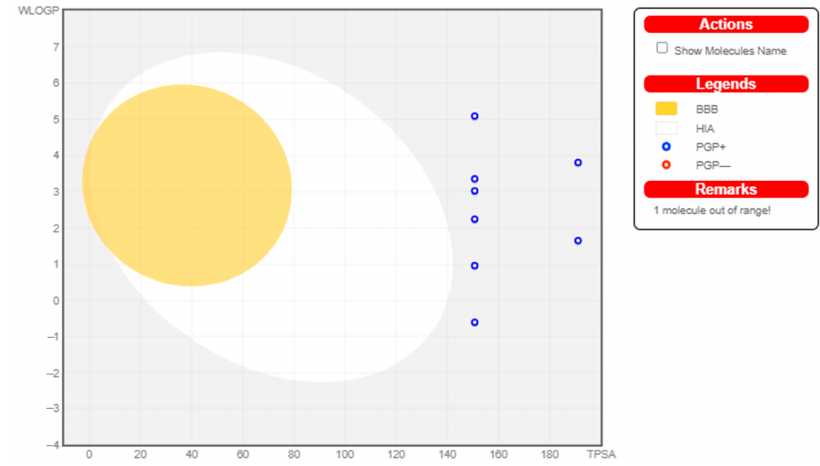
Figure 3. Swiss ADME Analysis of MZn1–MZn9.